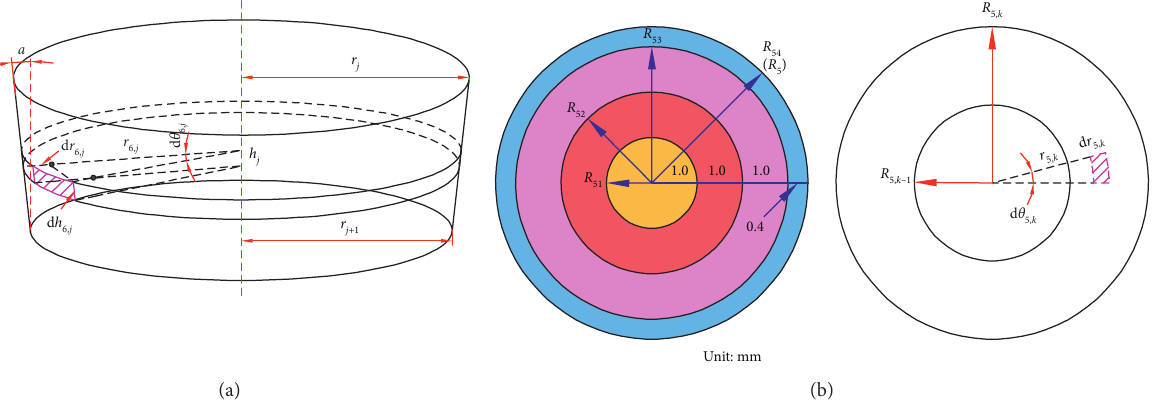
Figure 10: Infinitesimal segment areas from the pin surface in the MAM. (a) Pin side; (b) pin tip.